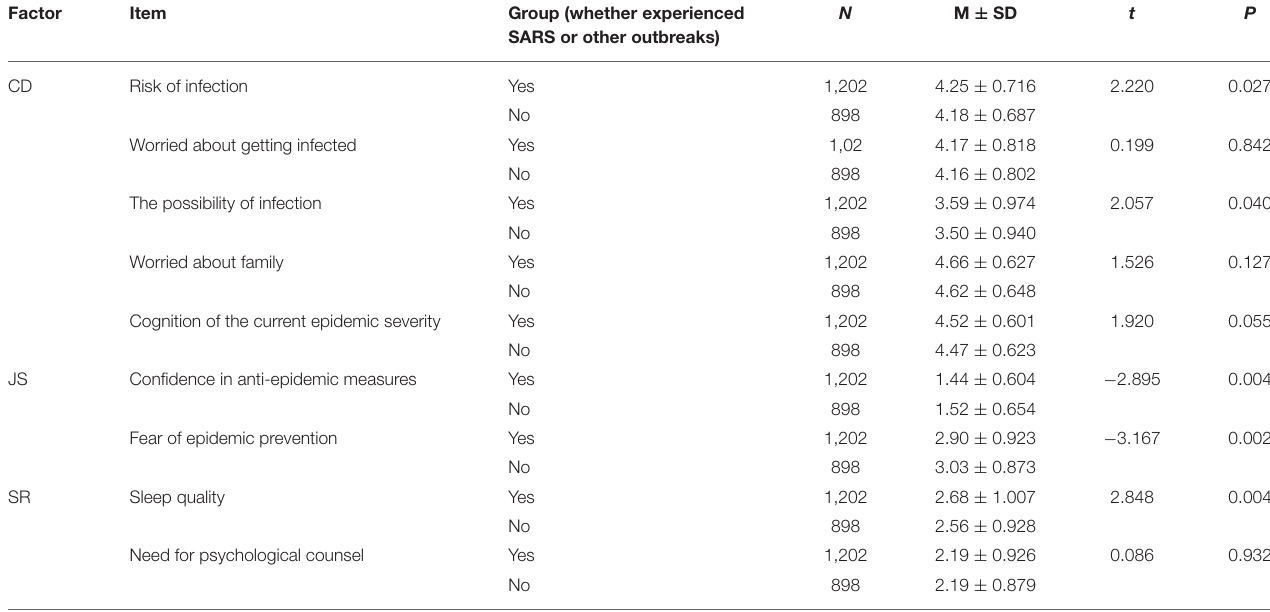
TABLE 5 | Differences in experience with SARS or other outbreaks.